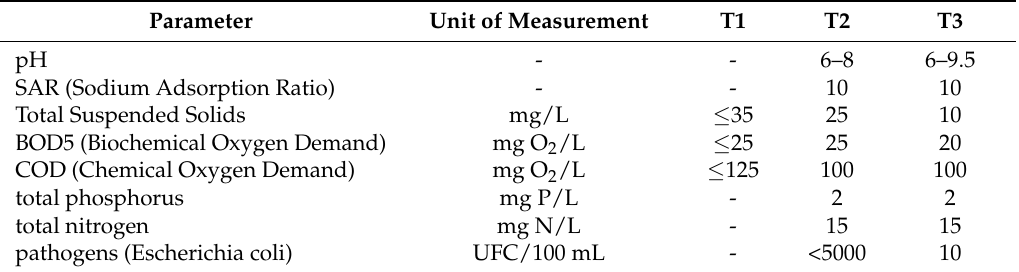
Table 2. Comparison of effluent standard quality requirements for discharge to surface water bodies (T1), ground surface (T2), and reuse